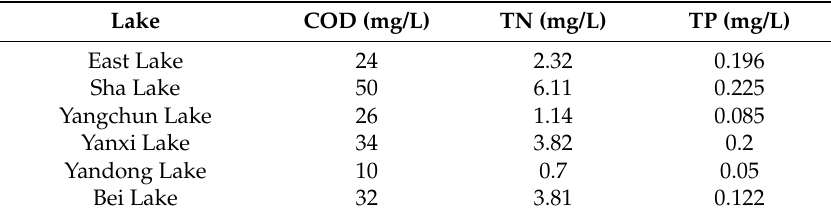
Table 11. Initial water qualities of the six lakes.